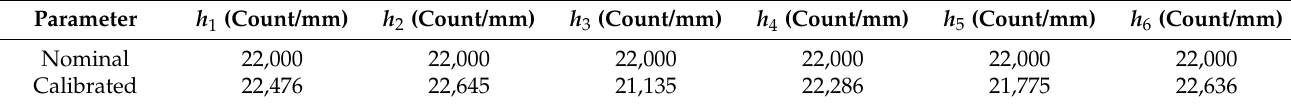
Table 3. Nominal and calibrated values of coefficients from motor positions to cable lengths.